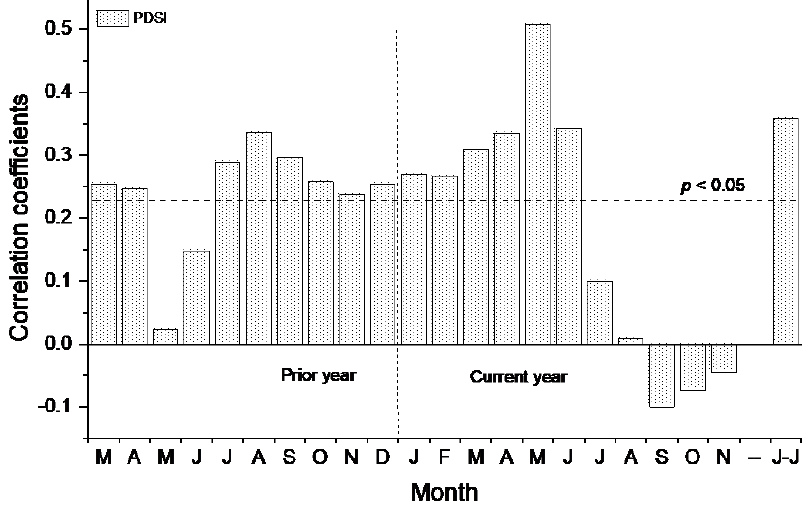
Figure 6. Correlations between PC1 and regional scPDSI (J – J: prior July to current June).